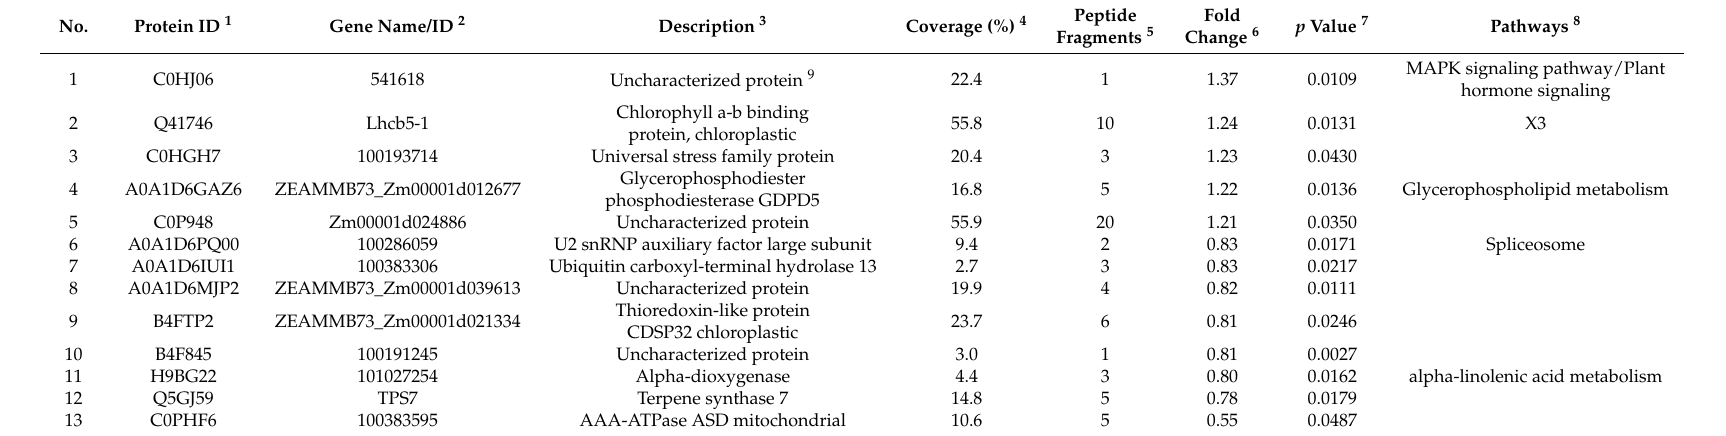
Table 2. Drought-responsive maize seedling leaf proteins observed specifically in tolerant line